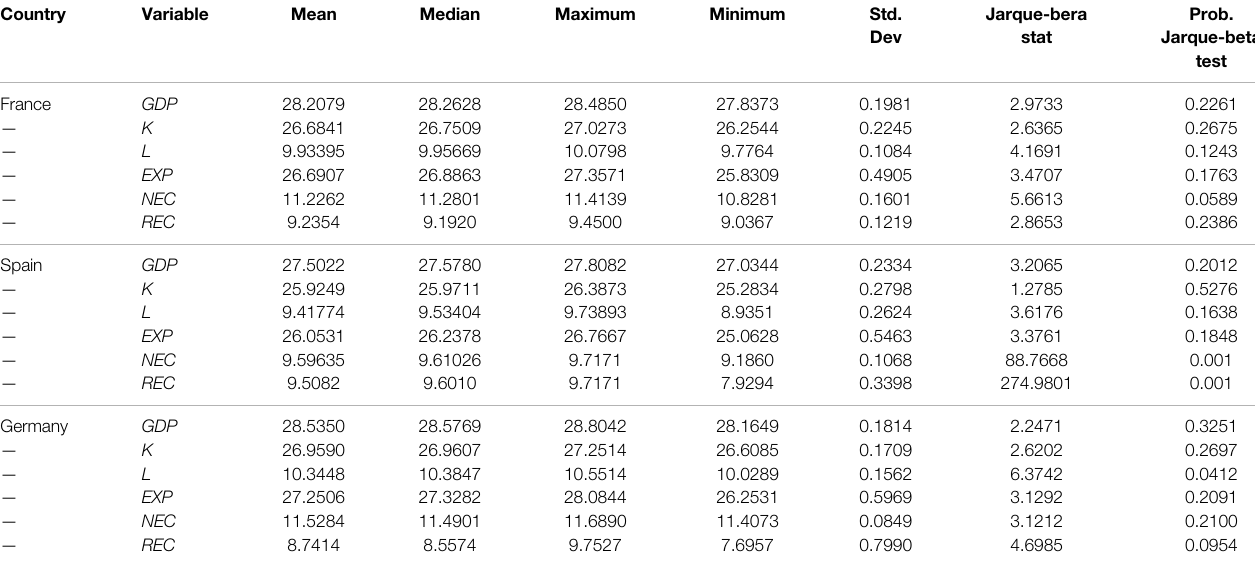
TABLE 4 | Descriptive statistics